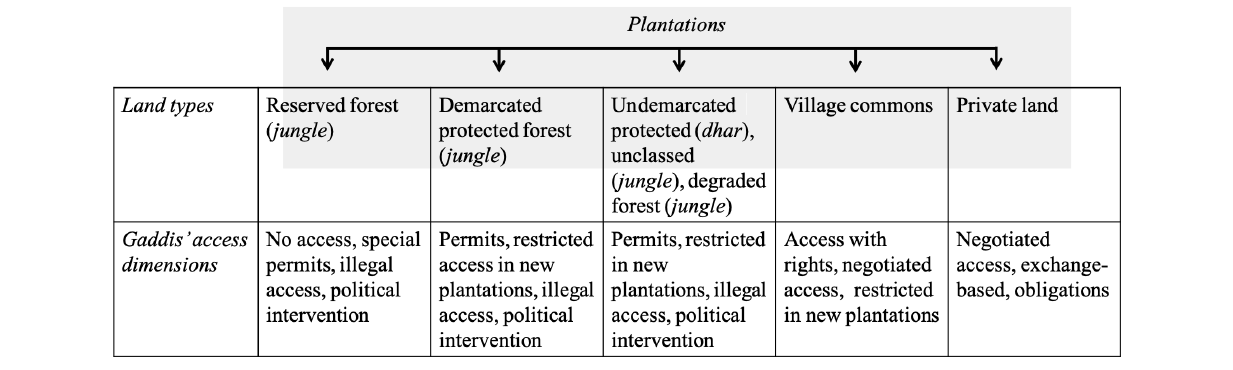
Fig. 4 . Land use types accessed by pastoralists and focus of plantation